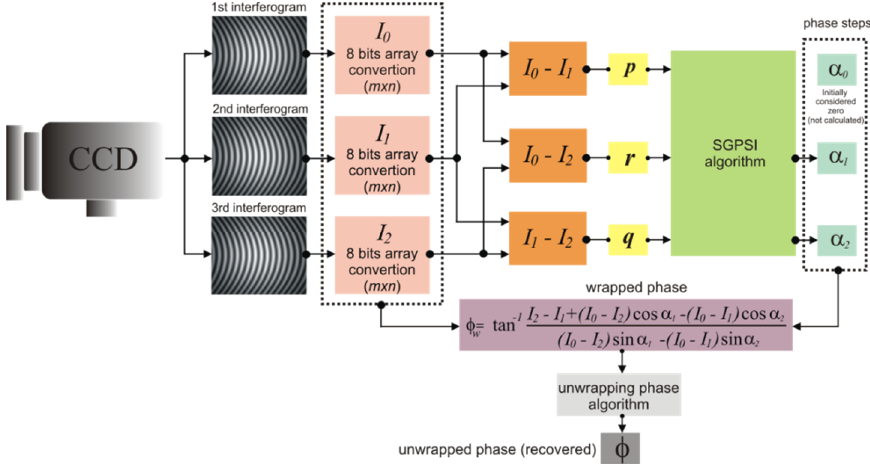
Figure 4. Block diagram of the implemented SGPSI algorithm for the phase